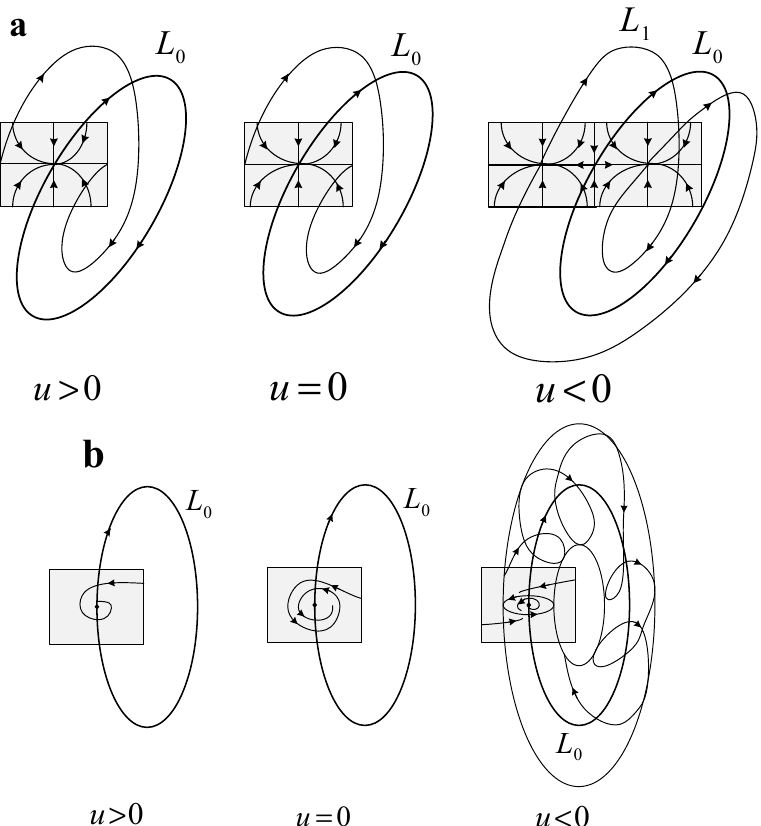
Figure 8. Codimension-1 bifurcation of limit cycles. ( a ) Periodic doubling bifurcation; ( b ) Neimark– Sacker bifurcation.